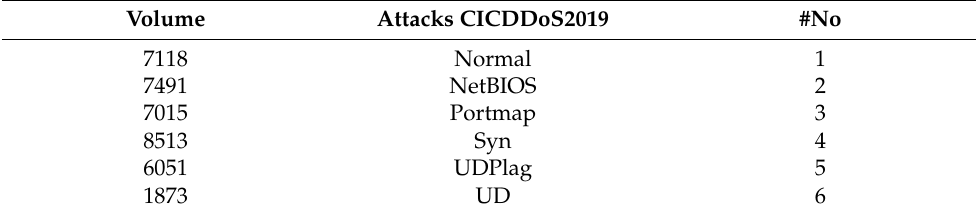
Table 1. Attacks on CICDDoS2019.